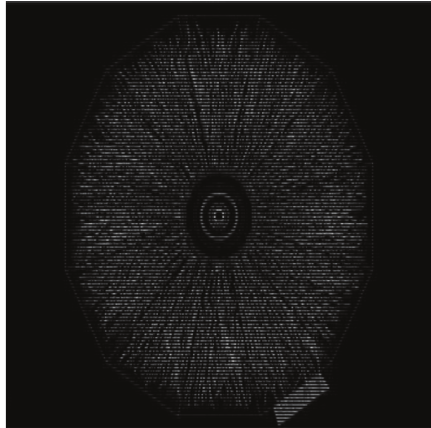
Figure 3: The reconstructed gray image of quark-gluon plasma. The dataoftheoriginalimageisencodedbythelocalframesofthefusion frame given by Example 14. The first coefficient of every local vector is deleted. The remained data is decoded by the dual fusion frame obtained by Example